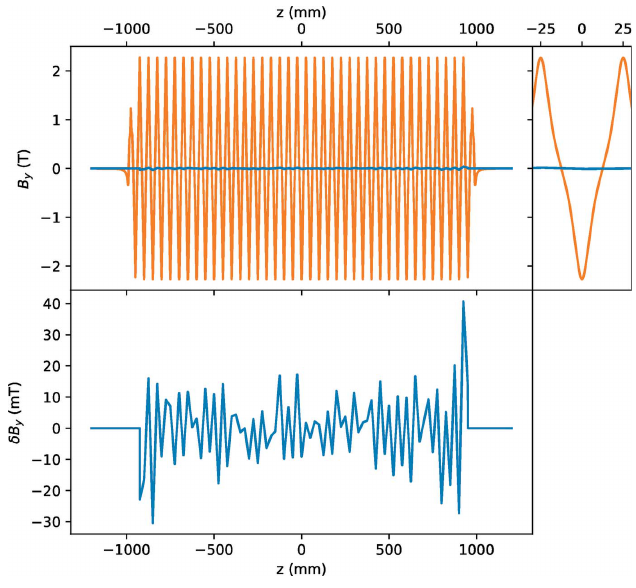
Figure 1 The vertical magnetic field of IVW50. Orange: ideal calculated field, also zoomed in the small right-hand panel. Blue in the top and bottom panels: measured deviation from the ideal